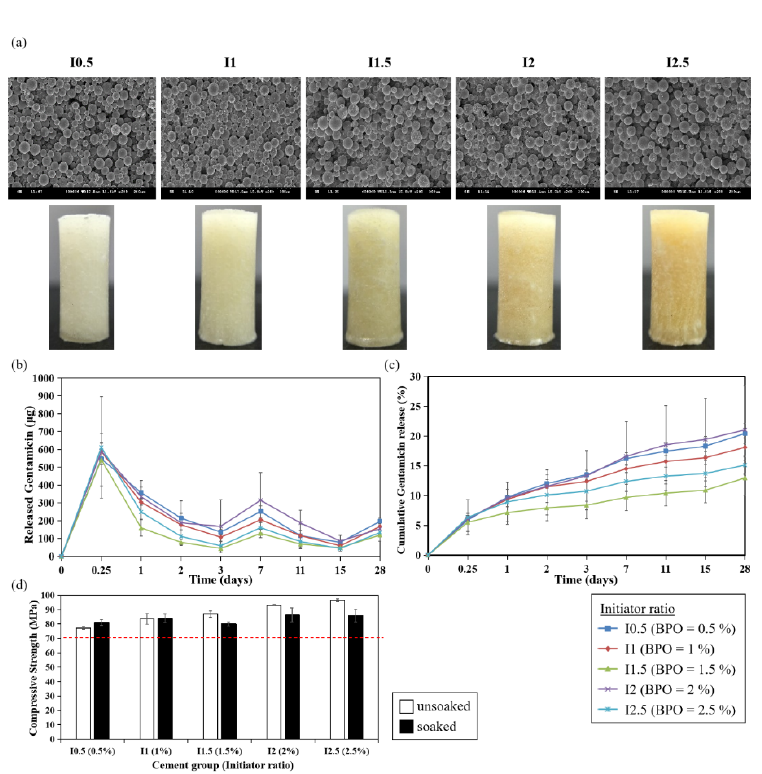
Figure 6. Effects of initiator ratio on antibiotics elution and compressive strength of PMMA bone cement. ( a ) SEM images and morphology of PMMA cement. ( b ) Gentamicin elution profile. ( c ) Cu- mulative gentamicin release percentage. ( d ) Compressive strength. White bar: unsoaked cement; black bar: PBS-soaked cement. The dashed line indicates the ISO standard for compressive strength (70 MPa).